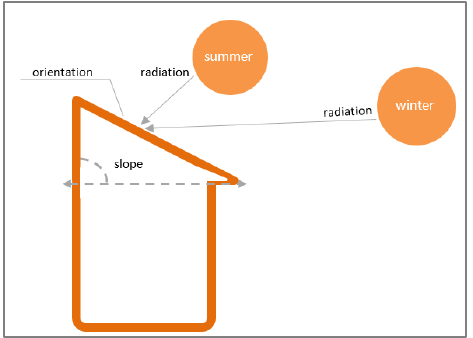
Figure 5. Parameters for suitability analysis of solar geographic potential.